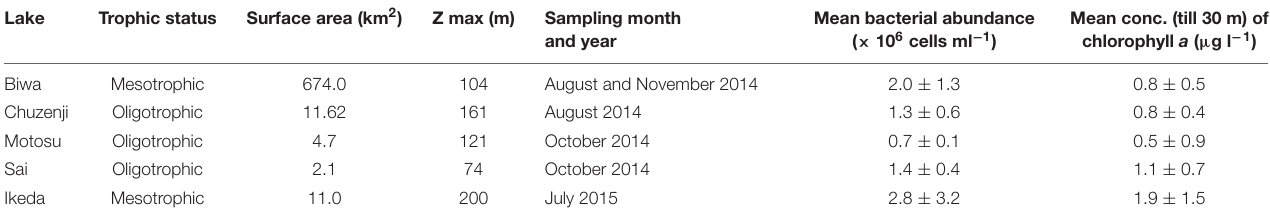
TABLE 1 | Characteristics and sampling information of each